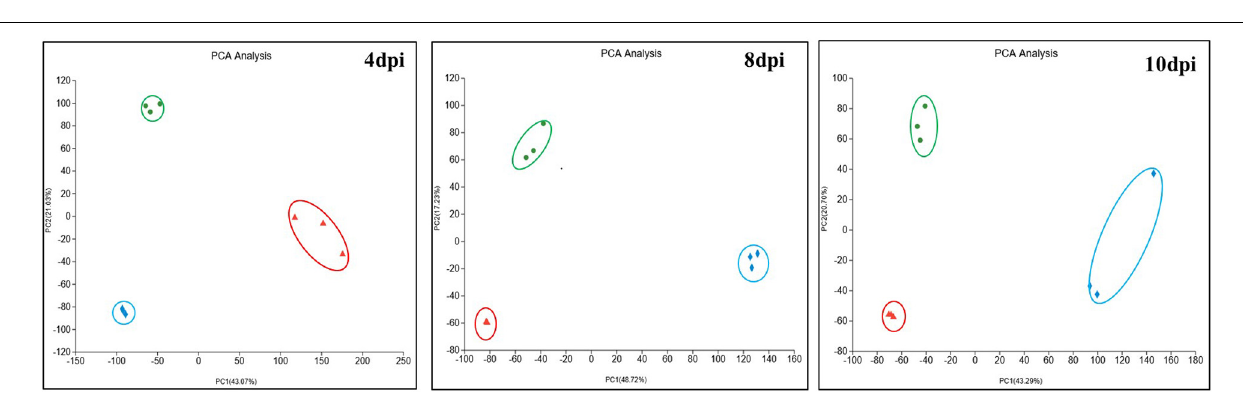
FIGURE 2 | Principal component analysis (PCA) of the samples from the three groups at 4, 8, and 10 dpi used ropls (R, Version 1.6.2) in the stats package with default parameters. Blue diamonds represent samples without added FeCl 3 (0Fe), green circles represent the treatment group with 20 µ mol/L FeCl 3 added (DC), and red triangles represent the treatment group with 400 µ mol/L FeCl 3 added